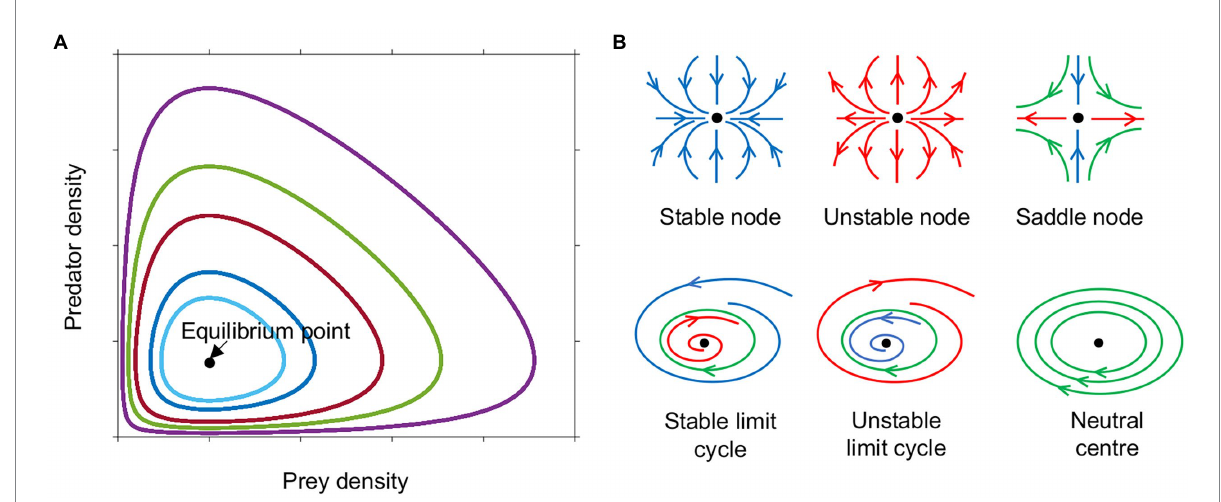
FIGURE 1 Phase plane diagram of ‘equilibrium’ points or dynamic steady states. (A) Phase plane diagram of a Lotka-Volterra system with different initial conditions of prey and predator density indicated by colour. (B) Phase plane trajectories of various types of equilibria. Arrows indicate direction of flow over time, blue towards the equilibrium point (black dot), red away from equilibrium, green around the equilibrium. Neutral centers occur in the Lotka-Volterra model (Figure 2A). When this model is modified to have logistic prey growth and a Holling type II predator functional response (Figure 2B), saddle nodes and stable limit cycles are observed. Monod kinetics for the prey combined with a Holling type II predator response (Figures 2C–F) can result in stable nodes, saddle nodes and stable limit